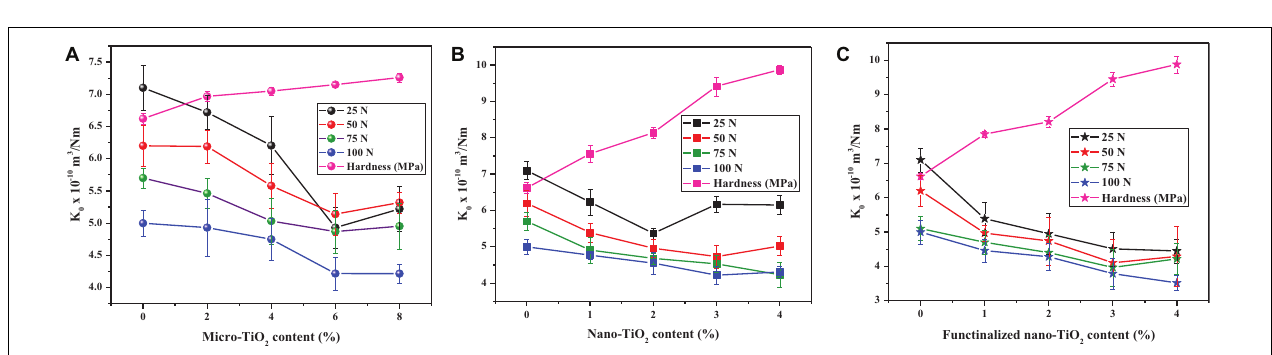
FIGURE 7 | Worn surfaces of composites disks (A) V 2 M , (B) V 2 N , and (C) F 2 N tested at 200 N, 0.15 m/s.